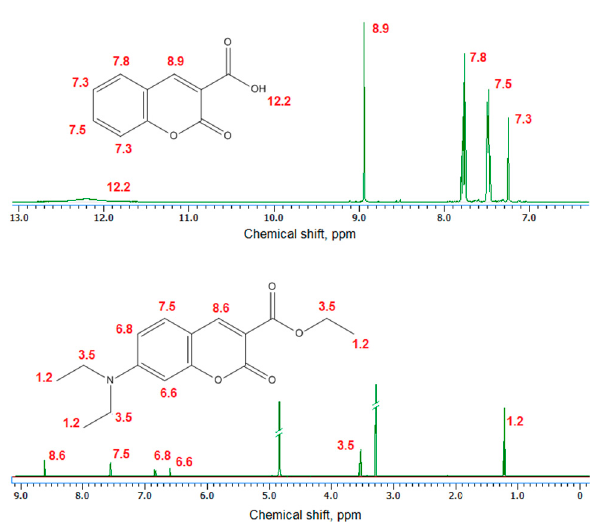
Figure 3. NMR spectra of the obtained coumarin derivatives. Figure 3 . NMR spectra of the obtained coumarin derivatives . Figure 3 . NMR spectra of the obtained coumarin derivatives .